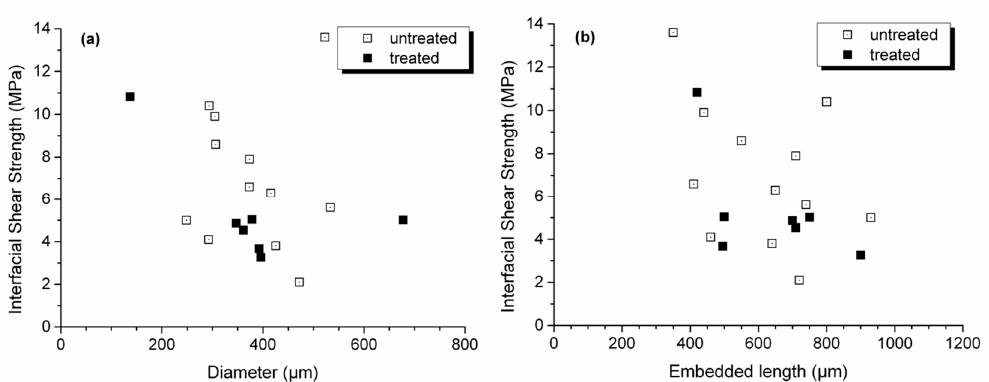
Figure 8. Apparent interfacial shear strength (MPa) between PLA and bamboo fibers (both untreated and mercerized) as a function of ( a ) equivalent diameter ( μ m) and ( b ) embedded length ( μ m). Only regular samples are represented.